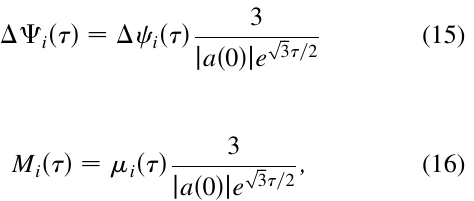
shifts linearly proportional to the FEL phase. The micro- bunch center in the high gain regime is located at (cid:5) (cid:1)(cid:3) (cid:2) (cid:6) (cid:4) ; M (cid:2) (cid:6) (cid:4)(cid:6) (cid:1) (cid:2) 0 ; (cid:7) 1 (cid:4) in Fig. 3. The electrons inside i i (cid:9) (cid:2) (cid:6) (cid:4) (cid:7) (cid:1)= 3 (cid:1) (cid:1)= 2 . The exponential decrease of the en-